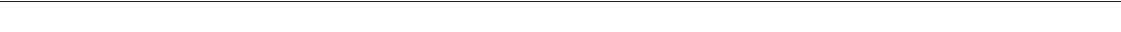
Fig. 6 ETSTY7 horizontal transfer between horse/equids and Parascaris . a Maximum likelihood tree for 73 ETSTY7 and ETSTY7 -like equid and Parascaris sequences (blue boxes) (sequence data Supplementary Data 7); copies veri fi ed to have originated from eMSY (red font) and sequences derived directly from horse and parasite samples noted; BS — bootstrap replicates; b HT validation by PCR using gDNA samples originating from 13 Parascaris individuals, tissues and developmental stages, C. elegans as negative invertebrate control, and male and female horses; Parascaris photo by R. Juras; primers represent the putative HT region ( ETSTY7 -3 exon3), Parascaris -speci fi c sequences (PEQ001.2), and three multicopy horse-speci fi c sequences - mtDNA ( ND1 ), olfactory receptor genes in chr14 (Chr14 CNV OR ), and a CNV in chrUn (ChrUn CNV); 100 bp ladder (NEB); c ETSTY7 -3 exon3 612 bp PCR amplicons from Parascaris individuals, tissues and developmental stages that were used for Sanger sequencing; d Reverse transcriptase PCR (RT-PCR) with ETSTY7 primers on a panel of 9 adult equine tissues showing testis-speci fi c expression; e – f FISH with 612-bp ETSTY7-3 PCR product in horse sex chromosomes (red FISH signals in e ) and metaphase spreads of donkey and two zebra species (green FISH signals in f ); scale bars 1 µ m; equid images purchased from Bigstock (https://www.bigstockphoto.com/), and g PCR with ETSTY7 -3ex3 primers in equids, Perissodactyls and unrelated diverse mammals showing that these sequences are limited to equids; M male; F female (see Supplementary Data 11 for primer information and Supplementary Note 6 and Supplementary Fig. 8 for more HT